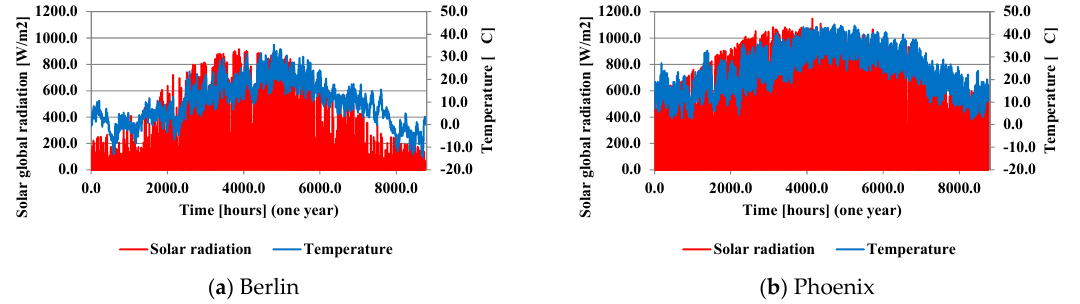
Figure 2. Global solar radiation on horizontal plane and ambient temperature.